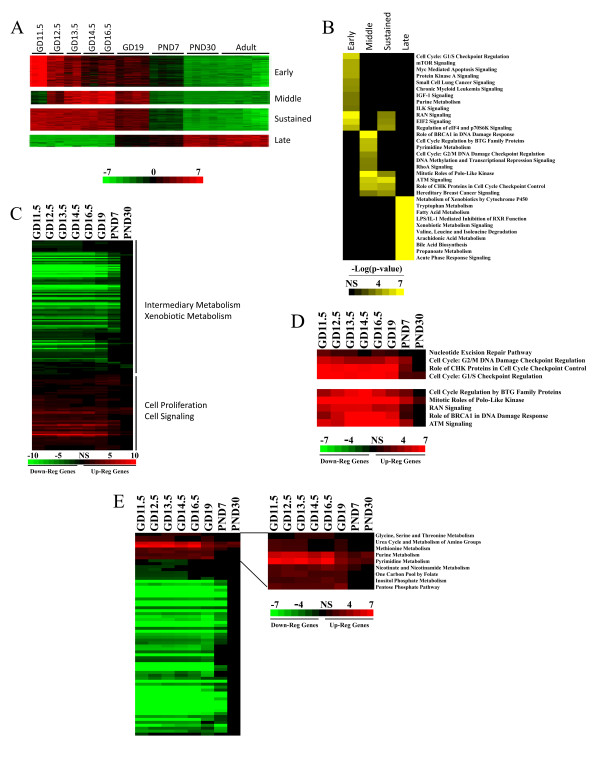
Canonical pathways altered in the developing liver. A. TightCluster groups genes into 4 temporal categories during liver development. Shown are examples of clusters that group genes into one of the 4 temporal categories. B. Genes expressed at different times during development fall into unique canonical pathways. Genes in the 4 temporal groups identified using TightCluster (Figure 2A) were analyzed using IPA. Only the top 10 significant pathways in the late group are shown. C. Global view of canonical pathways altered during development. Canonical pathways significantly altered at the indicated times during development compared to adult mice were identified using IPA. D. Increased expression of genes in canonical pathways involved in DNA maintenance and cell cycle (top) and cell fate signaling (bottom). E. Changes in canonical pathways of intermediary metabolism. Left, all significantly altered pathways of metabolism. Right, up-regulated pathways. For B-E, the scale numbers are the -log(p-value) and range from < 10-10 to not significant (NS). Yellow, altered pathway using all genes as input; red, up-regulated pathway using all up-regulated genes as input; green, down-regulated pathway using all down-regulated genes as input; black, not significant.